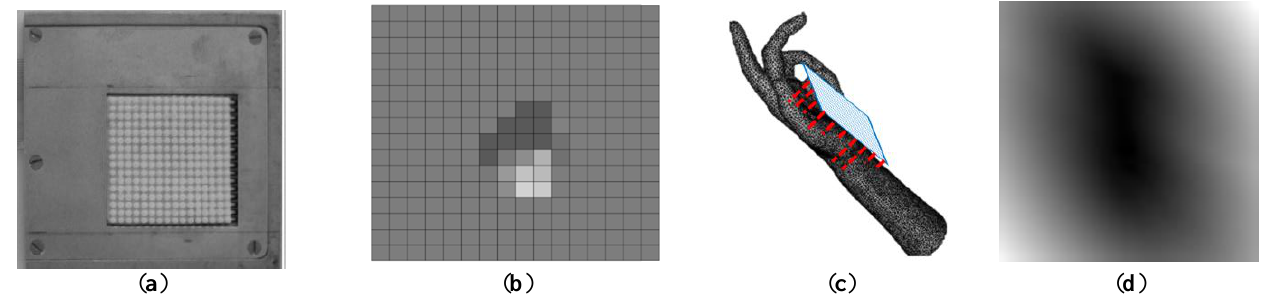
Figure 1. ( a ) Force-sensing resistor array, ( b ) example of tactile data, ( c ) simulated tactile sensor for the virtual environment, and ( d ) an example of a simulated tactile image.